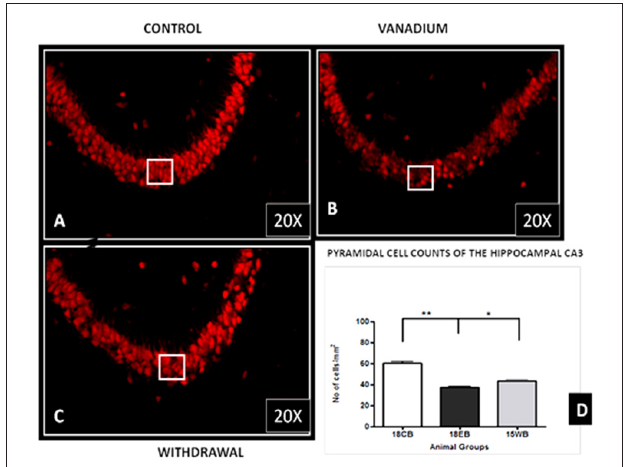
FIGURE 11 | Pyramidal cell loss of the hippocampal CA3 region after chronic vanadium exposure. NeuN immuno-histochemistry showed evidence of neuronal loss after 18 months of exposure. Quantitative analysis (D) revealed significant ( ∗∗ P < 0.001) decrease in the number of pyramidal neurones in the exposed groups (B) relative to the control (A) while the withdrawal groups (C) showed reversal effect with significant ( ∗ P < 0.05) increase in neuronal no relative to vanadium exposed groups (B) . Magnification: × 200, inset: × 400.